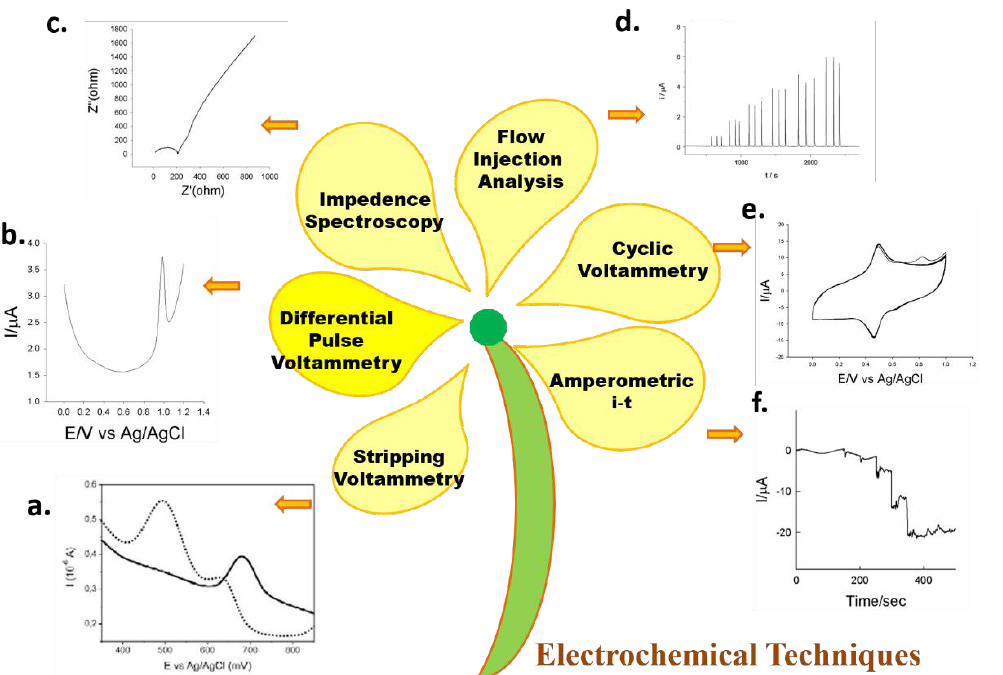
Figure 2. Mind map of the techniques used for the analysis of phyto-constituents using the Electrochemical Workstation and their graphic output images. ( a – f ) These include the techniques such as Electrochemical Impedance Spectroscopy, Flow Injection Analysis, Amperometric i-t technique, Cyclic Voltammetry, Stripping Voltammetry and Differential Pulse Volatmmetry. Each technique has its own characteristics, laws and theoretical relationships that helps in decoding the various aspects. Electrochemistry is a subject concerning the interlinking of chemical concepts based on the flow of electrons governing the product outcome. The field is generally based on green and environmentally friendly concepts, with the minimal use of reagents and organic solvents in the nano-scale operation of reaction protocols.